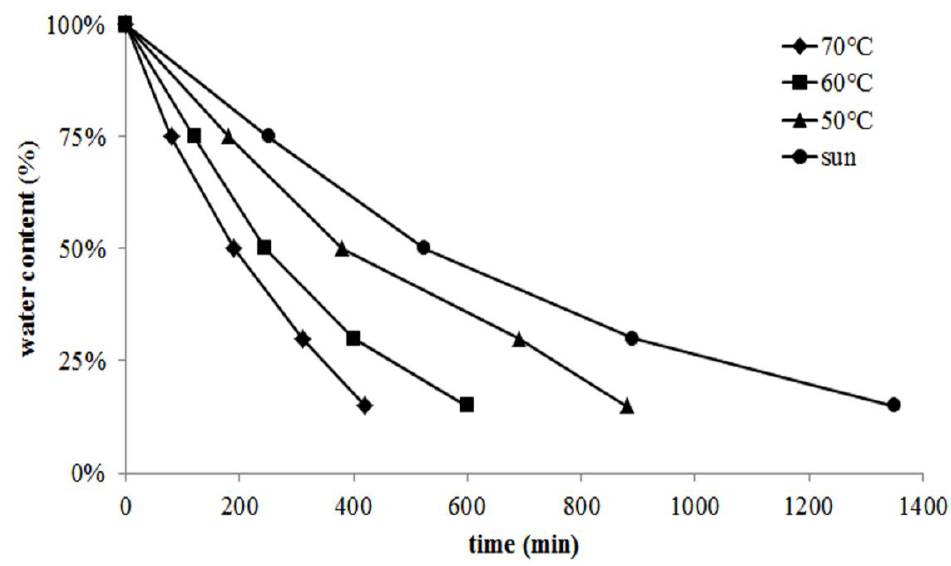
Figure 1. Kinetics of drying at different experimental conditions.